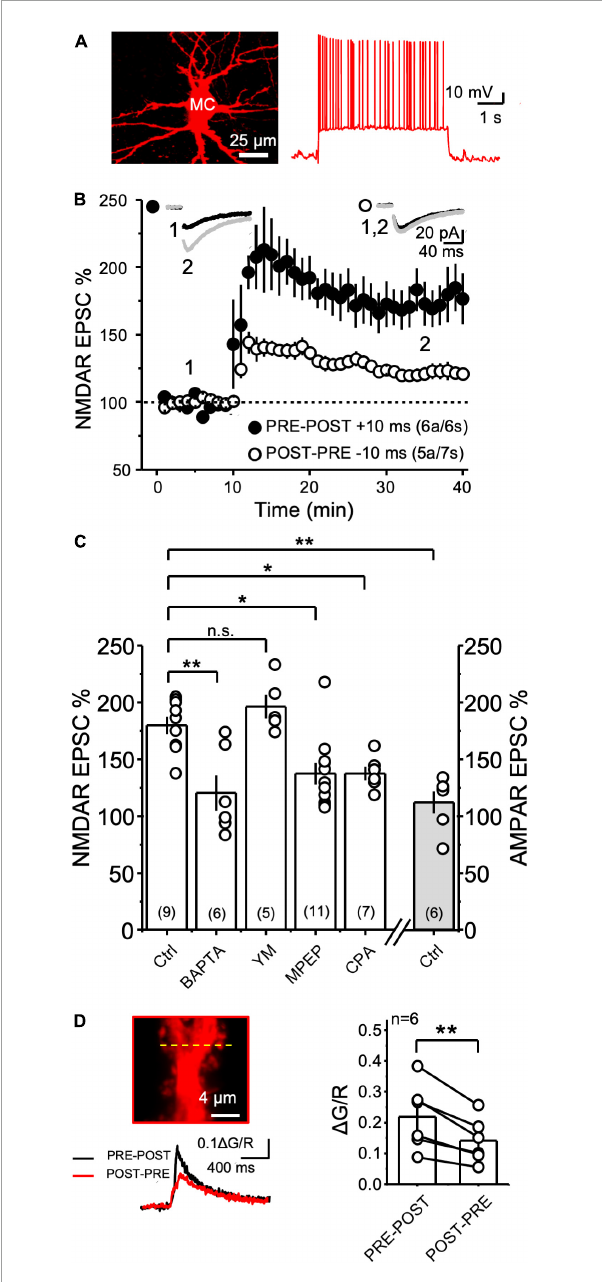
FIGURE5 NMDAR plasticity at the MF-to-Hilar Mossy Cells synapse. (A) Representative 2P reconstruction of a MC patch-loaded